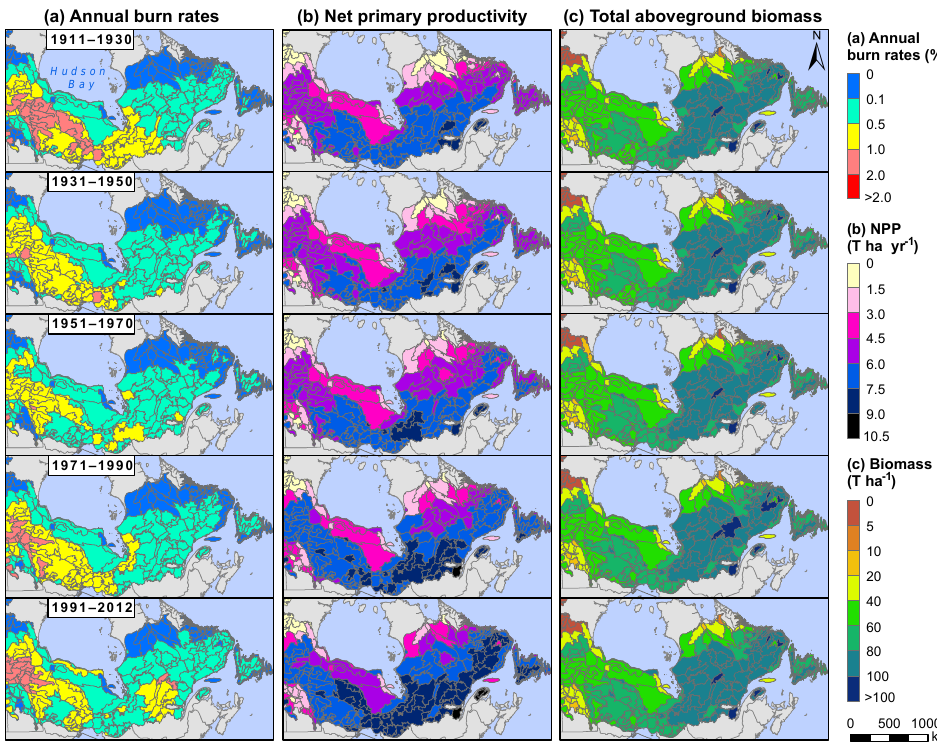
Figure 5. LPJ-LMfire-simulated (a) annual burn rates (%), (b) net primary productivity (Tha − 1 yr − 1 ), and (c) total aboveground biomass (Tha − 1 ) across eastern boreal Canada for five periods between 1911 and